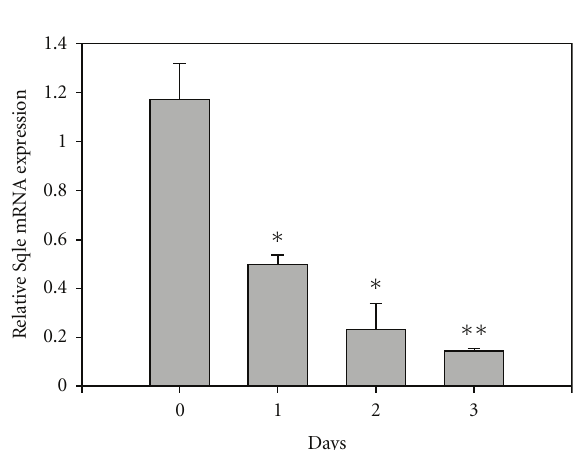
Figure 2: E ff ect of cholesterol feeding on hepatic squalene epoxi- dase mRNA levels. Rats were fed a diet containing 1% cholesterol for the indicated number of days. Hepatic mRNA levels were determined by RT-PCR. Values are given as means ± Standard Error for 3 to 6 rats per time point. ∗ P < 0 . 05; ∗∗ P < 0 .